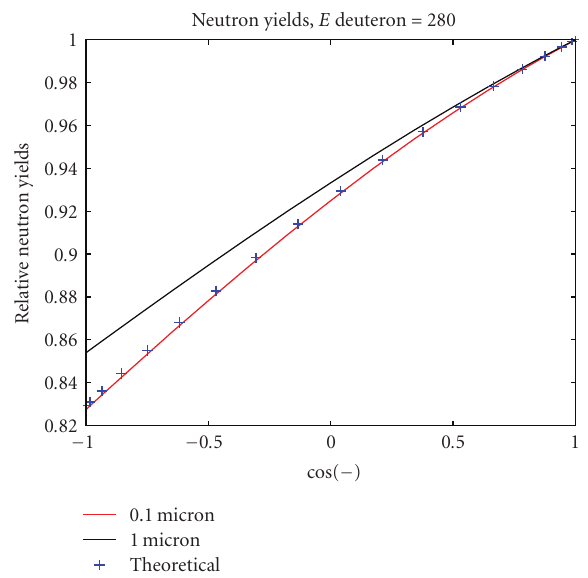
Figure 8: Ti target thickness e ff ect on D-T neutron yields-angle